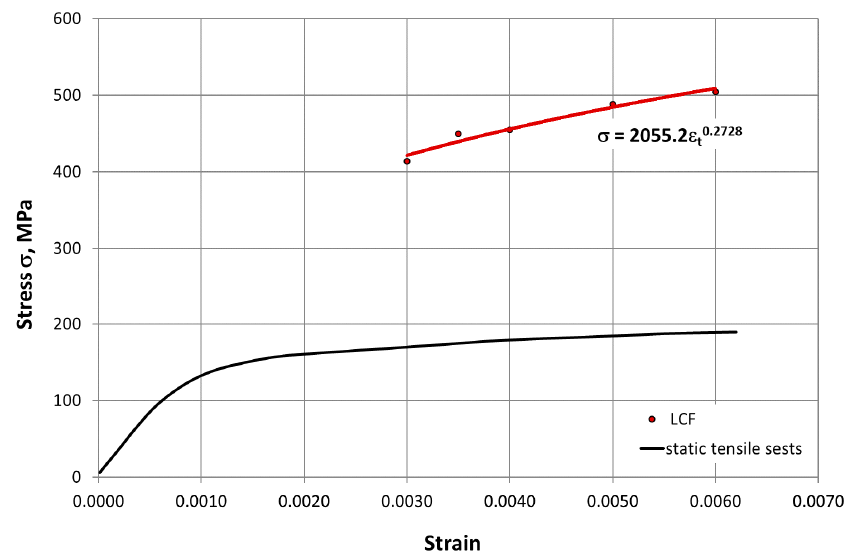
Figure 11. Cyclic strengthening curve for HR6W alloy at 650 °C against a curve determined in a static tensile test (LCF—Low Cycle Fatigue).